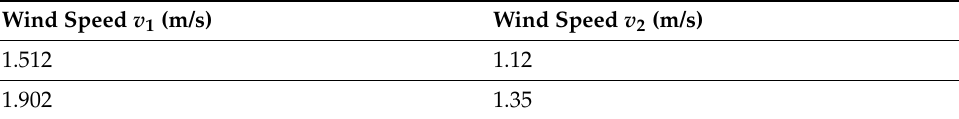
Table 13. Values of current speed before and after the rotor.